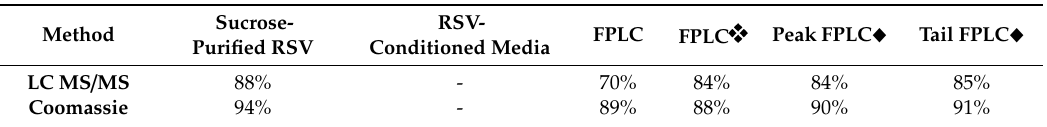
Table 1. Percent reduction in bovine serum albumin detected in purified RSV preparations compared to relative amount in RSV-conditioned media.